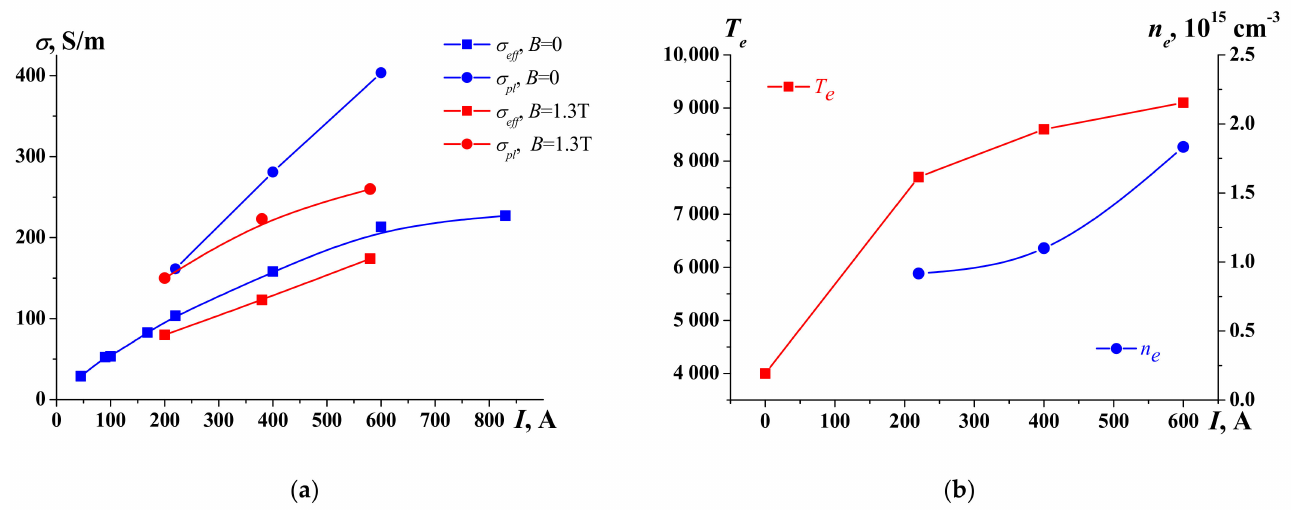
Figure 7. Dependence on the flowing current: ( a ) Conductivity in the core of the flow and effective conductivity; ( b ) Electron temperatures and